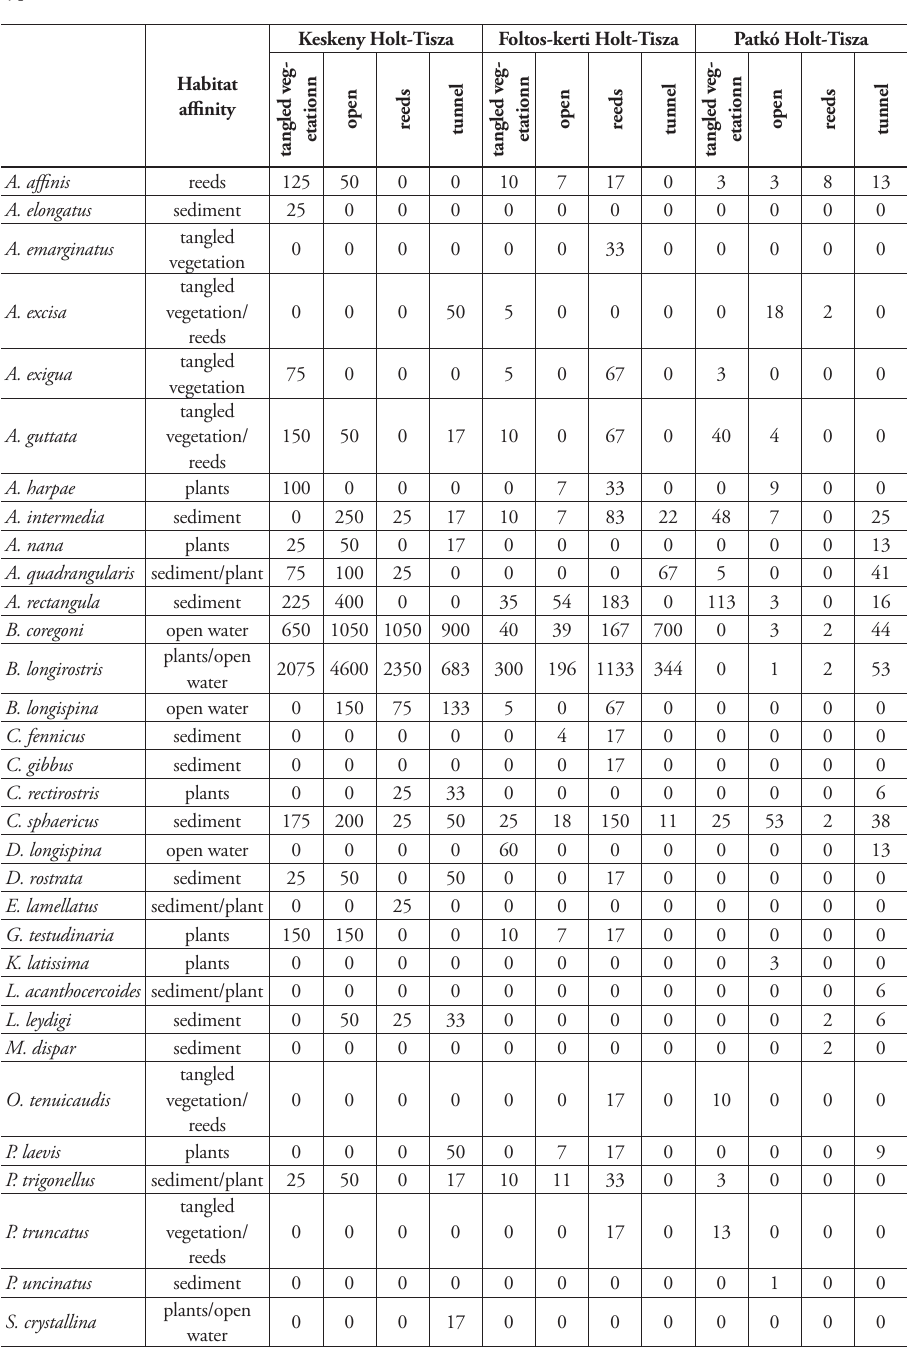
Table 1. Summary of Cladocera species and individual numbers based on the oxbows and vegetation types